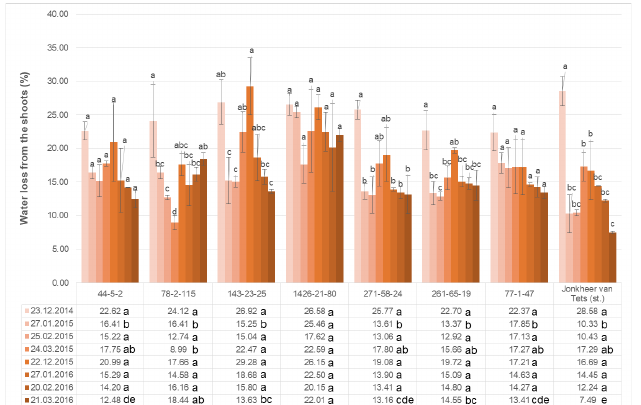
Figure 3. Water loss from the shoots of selected red currant genotypes during dormant period. (Letters above the columns are used to compare growing periods separately for each genotype; and letters next to the values in figure table are used to compare genotypes separately for each growing period. Different letters shown represent significant difference among the values according to Tukey’s HSD test).